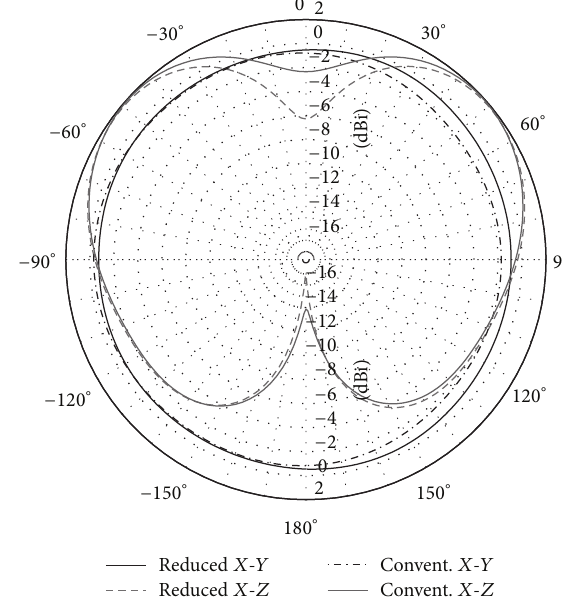
Figure 11: Comparison of radiation pattern of conventional and reduced